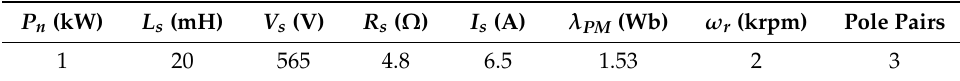
Table 4. PMSG technical data.